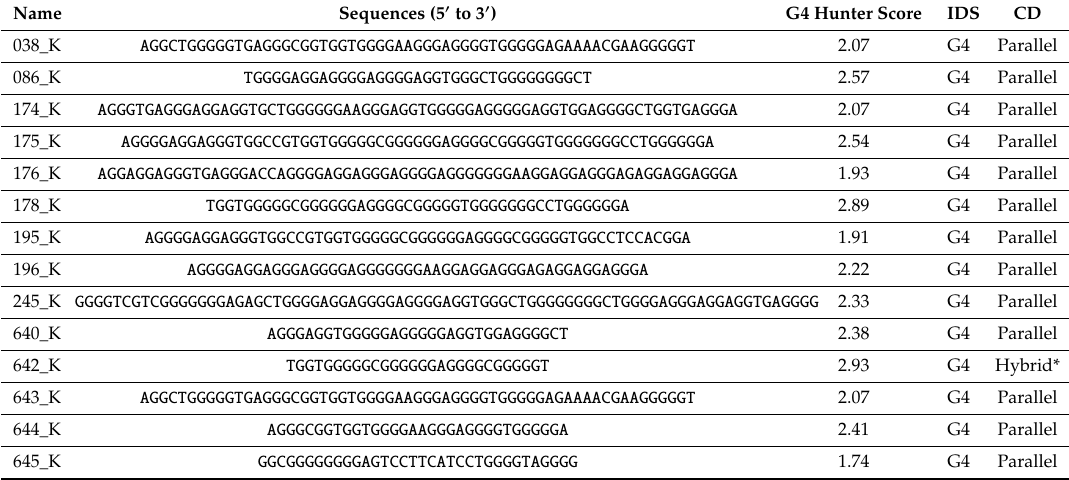
Figure 6. Relationship between the observed frequency of PQS per 1000 bp and GC content. Di ff erent G4Hunter score intervals are considered. In each G4Hunter score interval miniplot, frequencies were normalized according to the highest observed frequency of PQS. Organisms with max. frequency per 1000 bp greater than 50% are described and highlighted in color. Table 4. Long G4-prone motifs with high G4HS found in Hadesarchea archeon